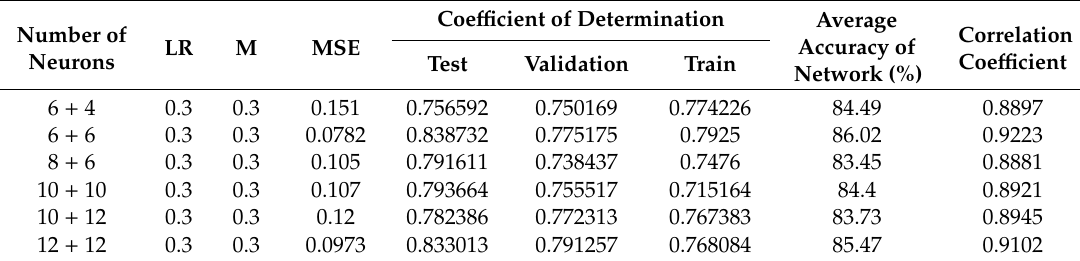
Table 2. Quantitative indicators for evaluating networks developed using gradient descent with momentum algorithm.